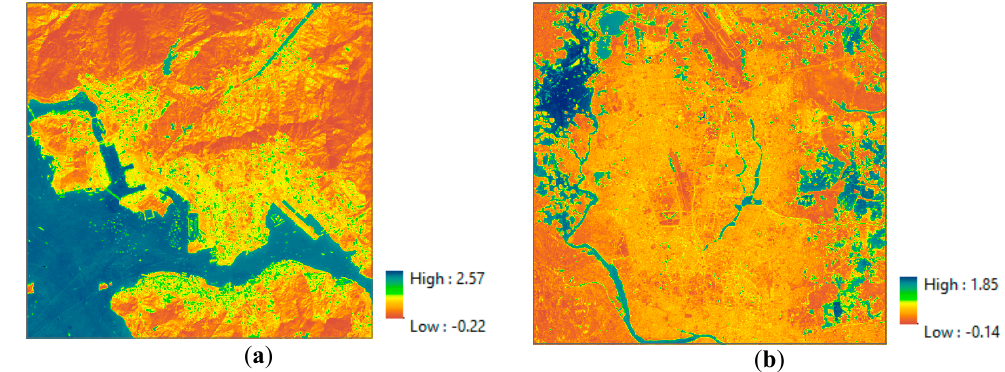
Figure 14. ShDI-based maps of the two study sites: ( a ) Hong Kong and ( b ) Dhaka.